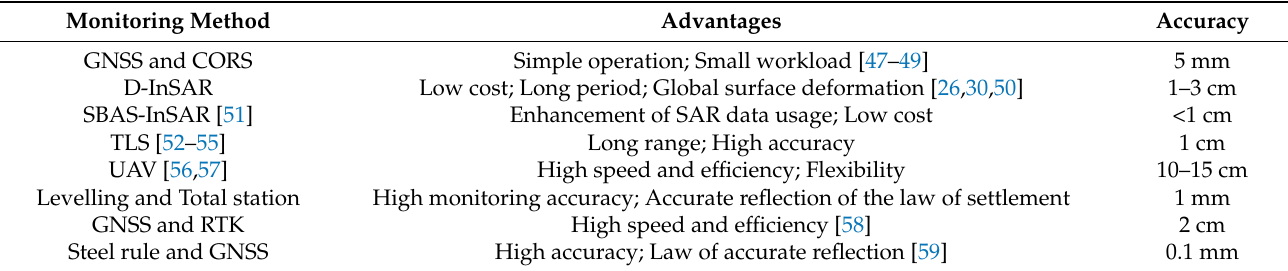
Table 1. Common ground deformation monitoring techniques.